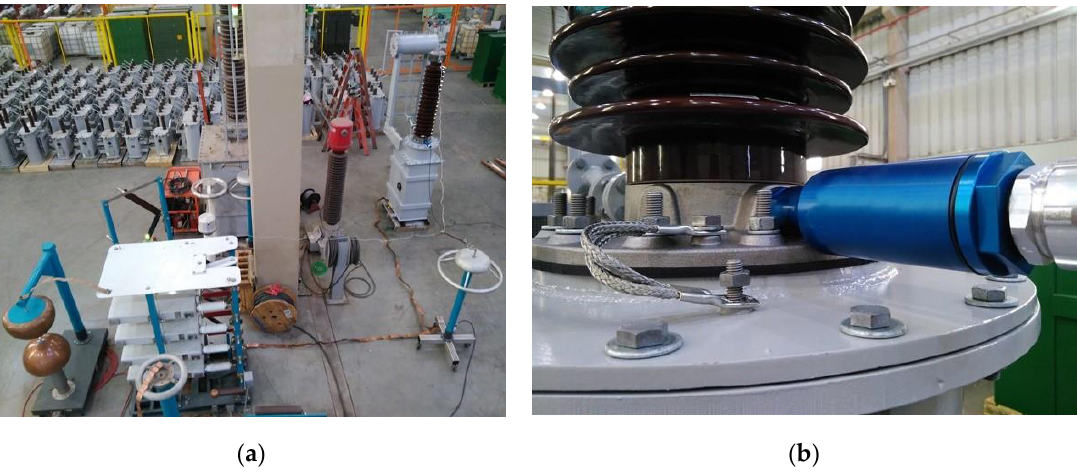
Figure 12. Laboratory tests. ( a ) Testing structure. ( b ) Coupling device connected to the transformer bushing.